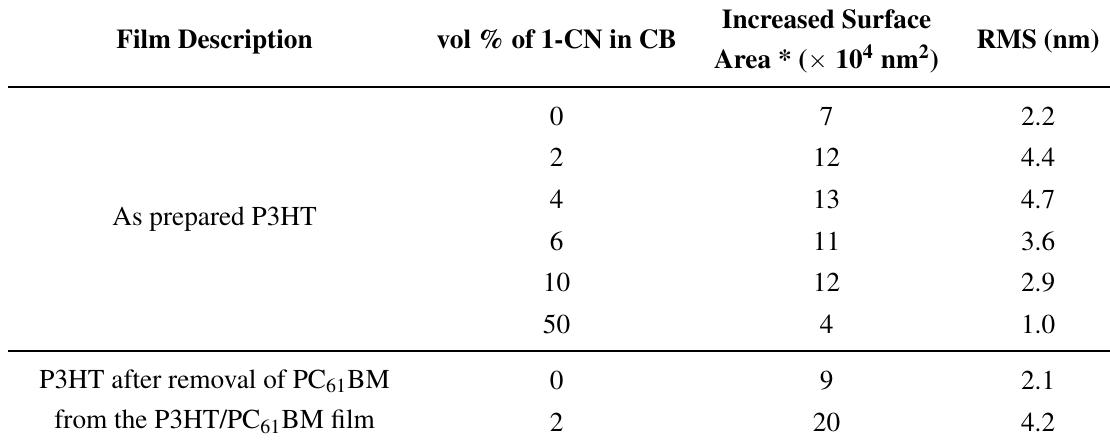
Table 1. RMS roughness and surface area data of P3HT films prepared from the CB solution containing different concentrations of 1-CN.